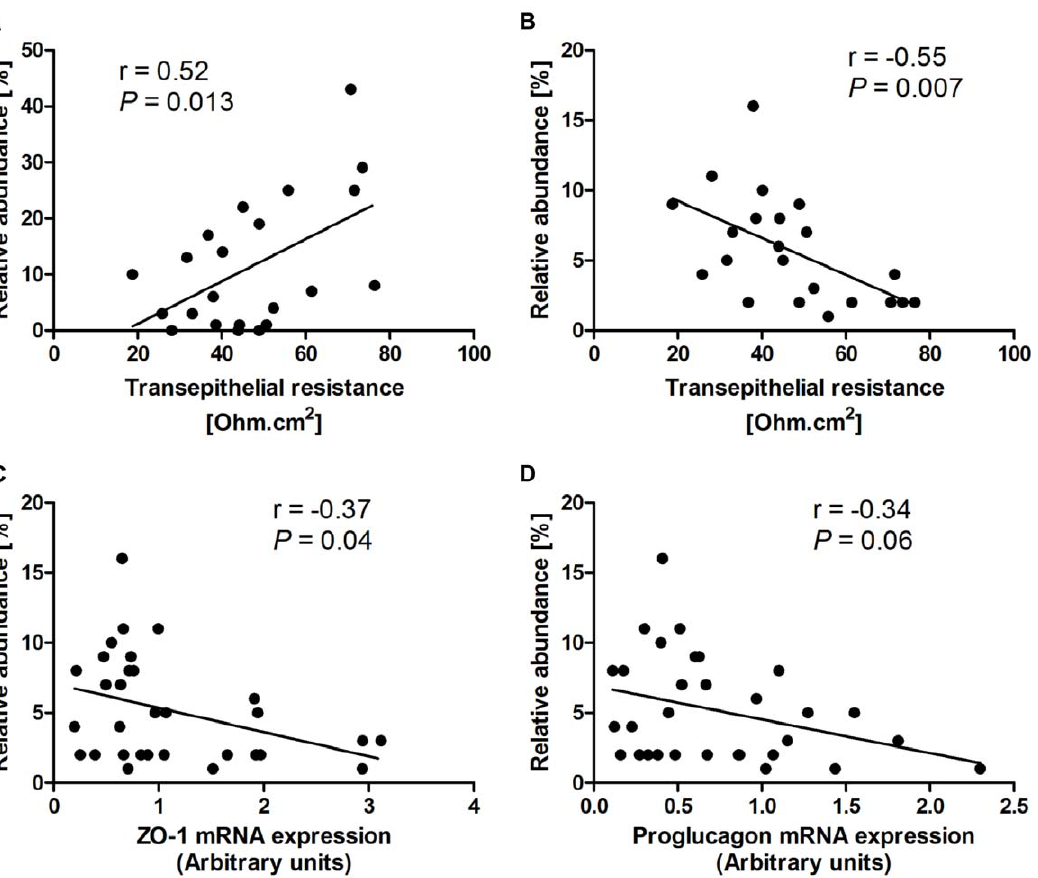
Figure 5. Correlations between Lactobacillus (A) and Oscillibacter (B–D) abundances and permeability parameters in proximal colon. Gut microbiota profile was determined as described in Figure 4 (n=22–31). Transepithelial resistance and mRNA expression of zona occludens (ZO)-1 and proglucagon in proximal colon were measured as described in Figure 3.